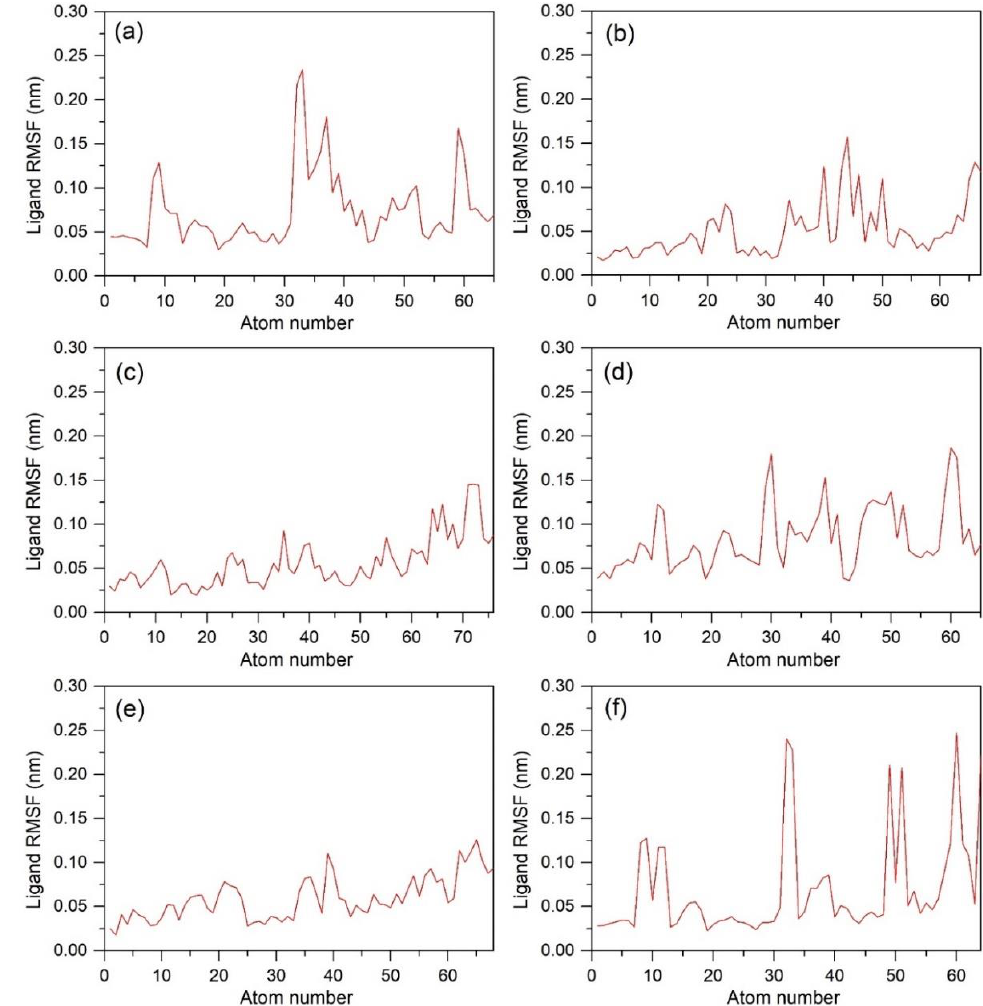
Figure 4. RMSF (root mean square fluctuation) for all atoms for each compound ( a ) Catechin 3,7,-Di- O -Galate, ( b ) Catechin 5,7,-Di- O -Gallatec, ( c ) Catechin 5,4 ’ -Di- O -Gallate, ( d ) Epifisetinidol-(4beta->8)-Catechin, ( e ) Catechin 3- O -Rutinoside, ( f ) Epicatechin (4b->6) Catechin.